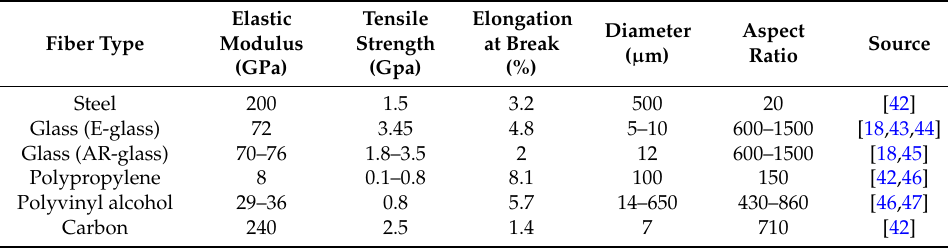
Table 1. Typical mechanical properties of fibers.